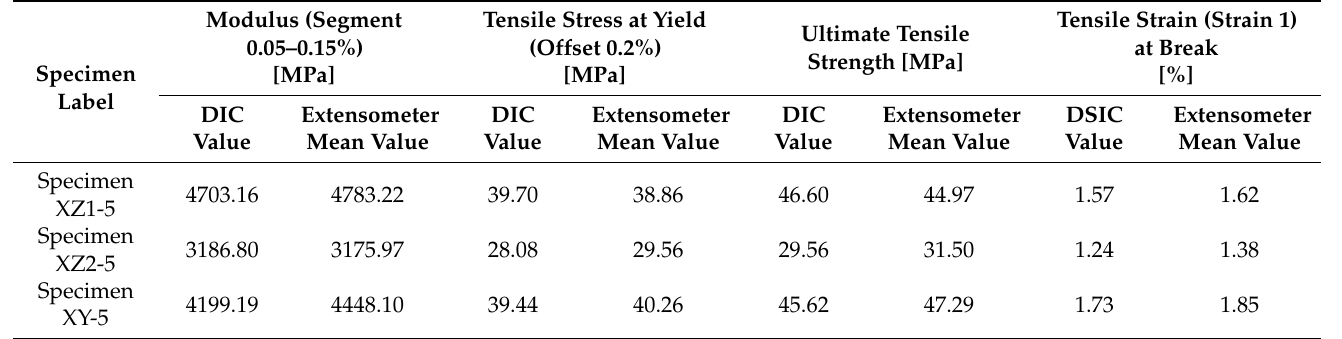
Table 6. Comparison between values obtained with DIC. measurement system and digital exten-